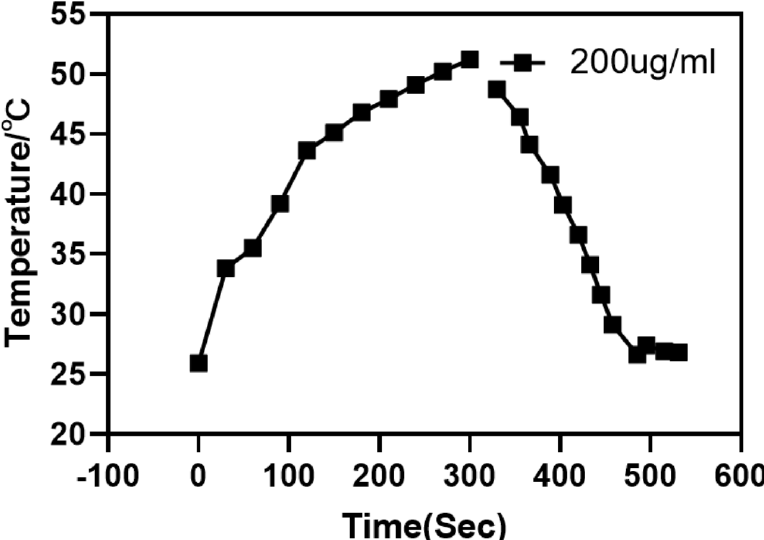
Figure 12. 980 nm wavelength of near-infrared light excites the temperature rising-falling curve of 200 µ g/mL of Ag-UCNPs@SiO 2